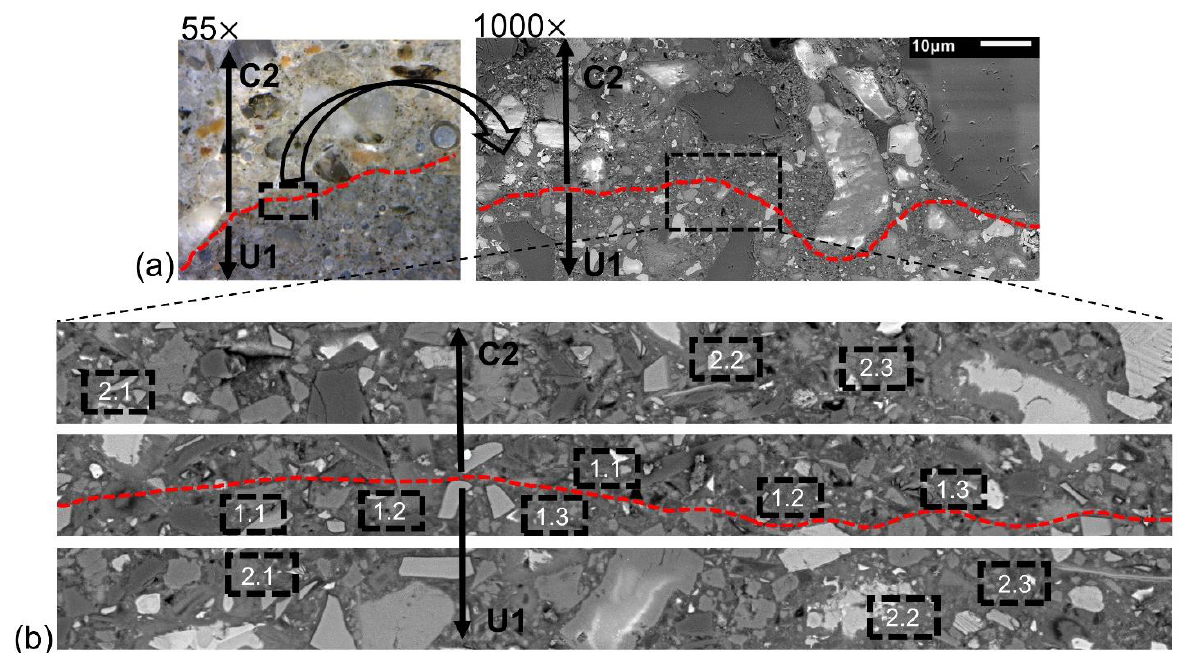
Figure 2. ( a ) Digital microscope image and “stitched” BES-SEM image with the rectangular area selected for porosity quantification, ( b ) Example of areas selected for the image analysis.